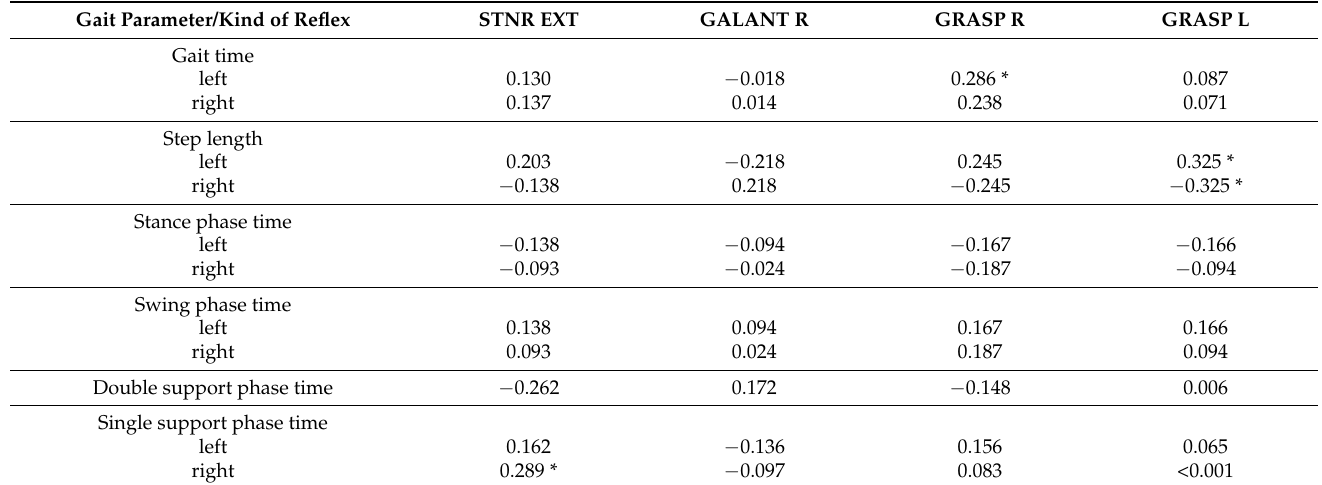
Table 4. Spearman’s correlations between selected reflexes and gait parameters are mostly divided into left and right side. Gait time, step length, stance and swing phase time, double and single support phase time, along with some of the primitive reflexes’ correlations are